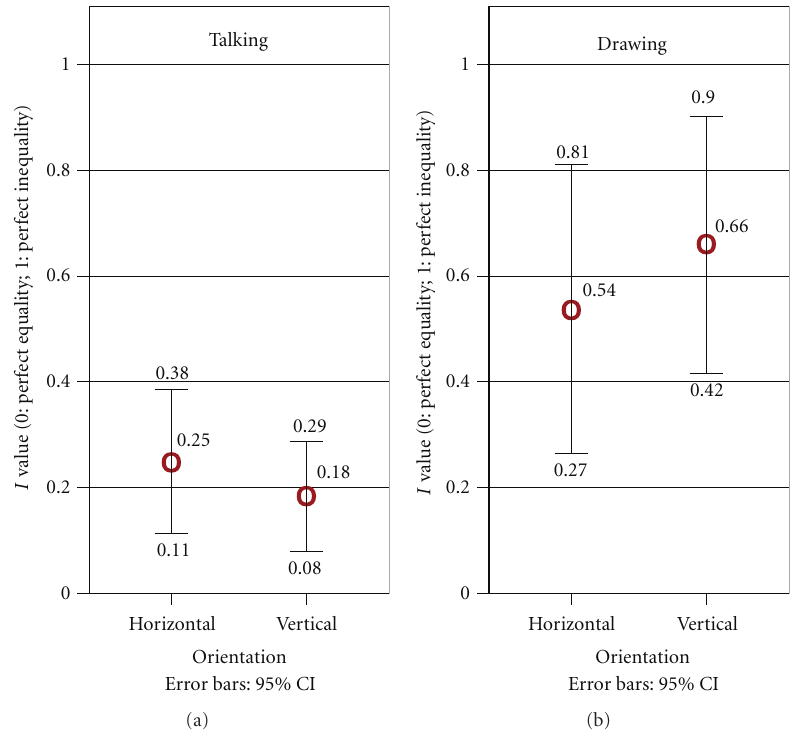
Figure 7: Equality of (a) talking and (b)